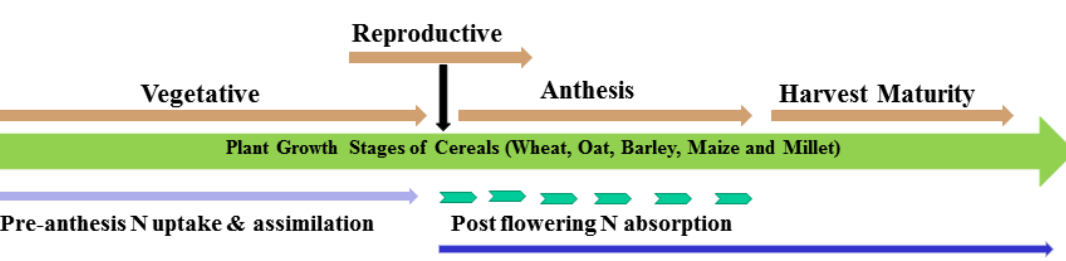
Figure 2. Generalized N cycle representing different inputs, losses, and plant uptakes for C 3 and C 4 cereal crops.